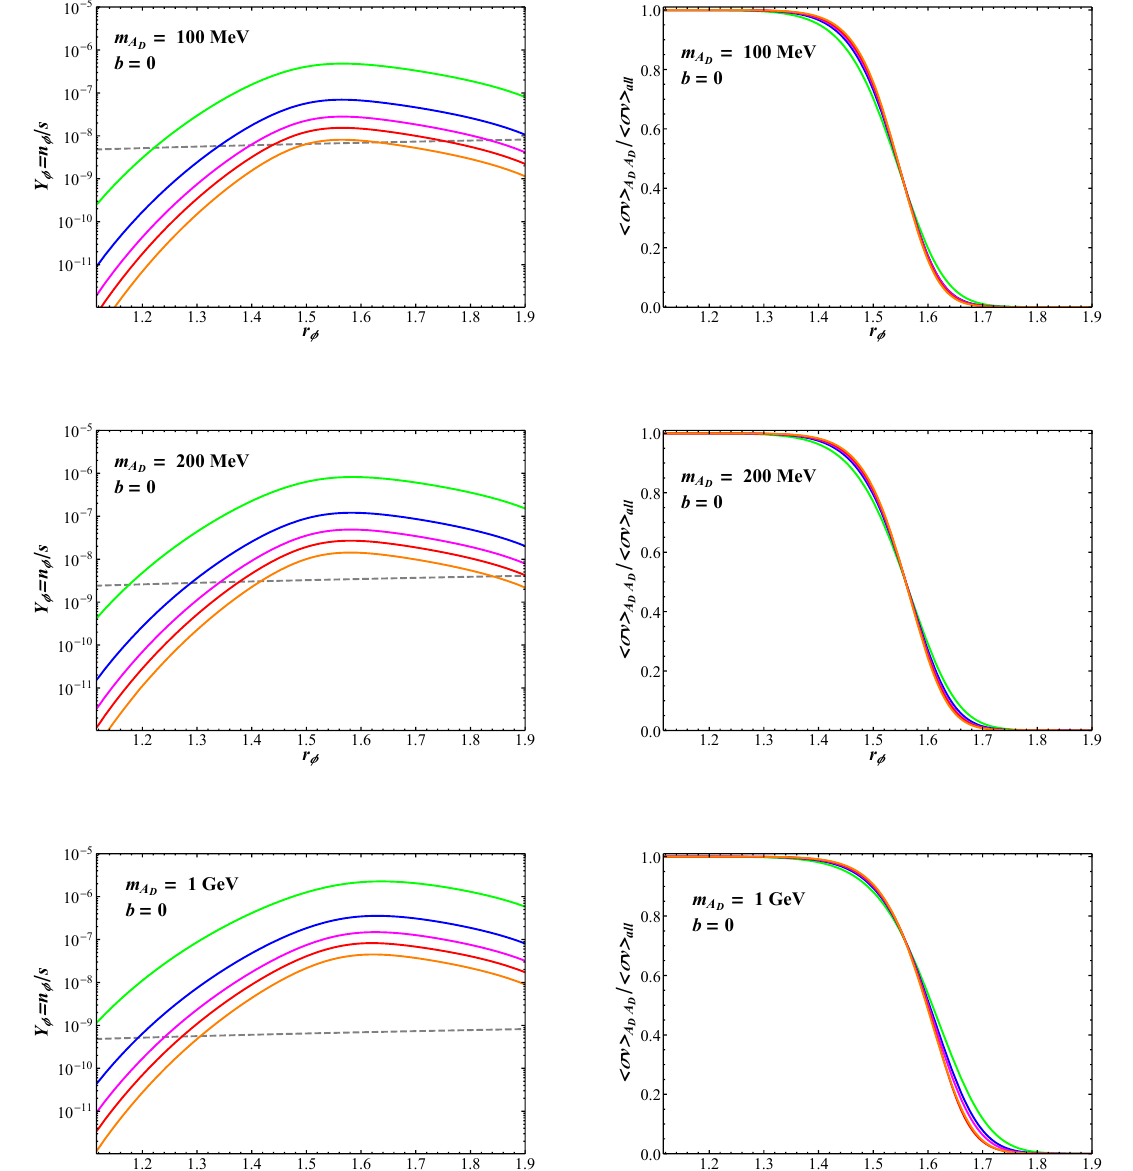
Figure 5. (Left) The DM yield Y φ as a function of r φ in the absence of any dark Higgs contributions to the DM annihilation cross section ( b = 0 ) for m A = 100 MeV (Top), m A = 200 MeV (Middle), D D and m A = 1 GeV (Bottom). Each chart depicts the results for three different selections of g D : D g D = 0 . 1 (Green), g D = 0 . 3 (Blue), g D = 0 . 5 (Magenta), g D = 0 . 7 (Red), and g D = 1 (Orange). The Y φ value to recreate the observed relic abundance, Y φ = (4 . 32 10 − 10 ) ( GeV /m φ ) [40], is × × displayed on each chart as a dashed gray line. (Right) Same as the right, except the fraction of the thermally averaged annihilation cross section that stems from the kinematically forbidden process φ ∗ φ A D A D at freeze-out is →